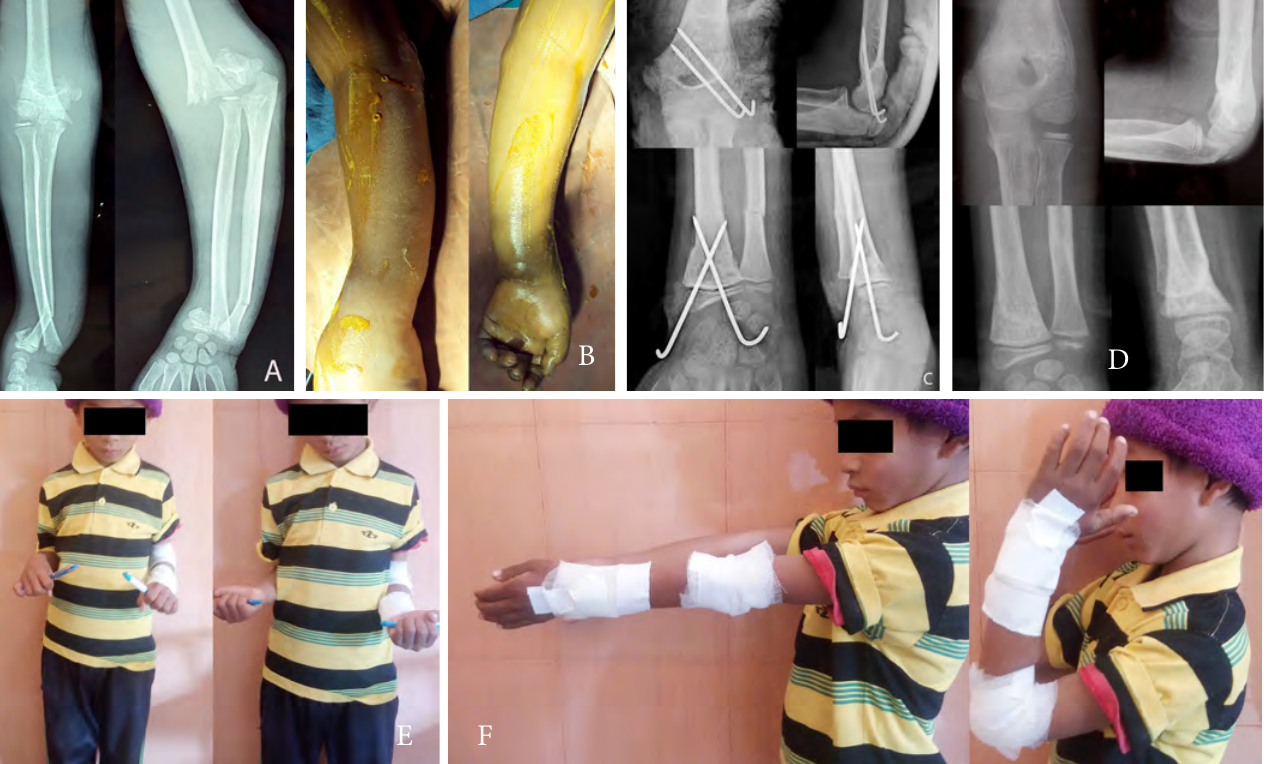
Fig 2 : A . Radiographs of a 9-year-old boy with open (Gustilo I) displaced supracondylar fracture and closed distal radius and ulna fracture after a fall from tree. B. The deformed limb; C. After closed reduction, K-wire fixation of the elbow distal radius. D. After removal of K-wires at 8 weeks. E,F. Final excellent outcome according to modified Flynn criteria.